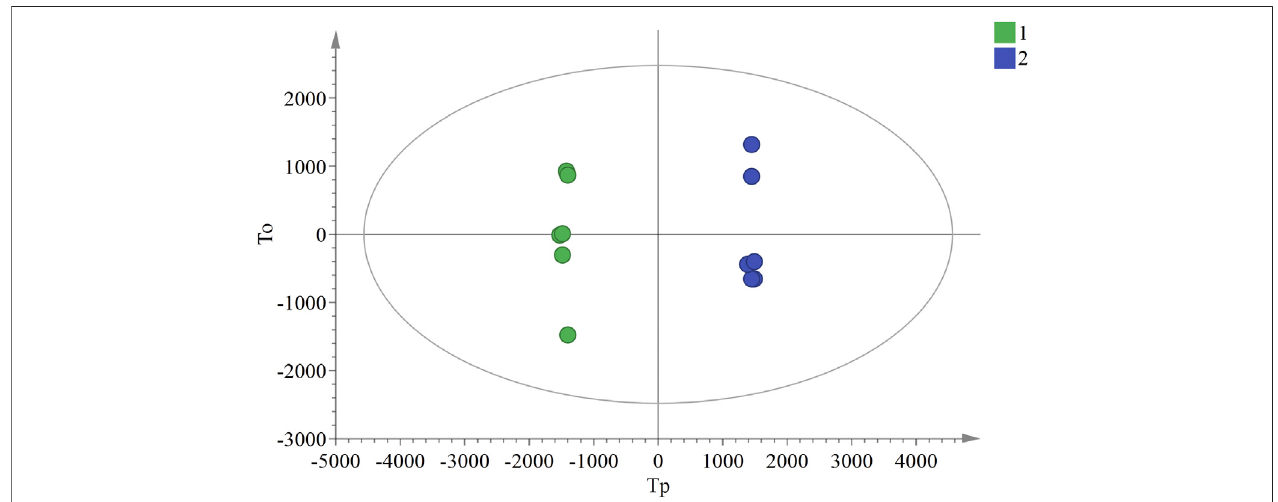
FIGURE4| OPLS-DAscorechartofULRAandYFgroups.GreendotsareULRAgroup,andbluedotsareYFgroup.OPLS-DA,partialleastsquaresdiscrimination analysis; ULRA, unprocessed lateral root of Aconitum carmichaelii ; YF, Yinfupian.